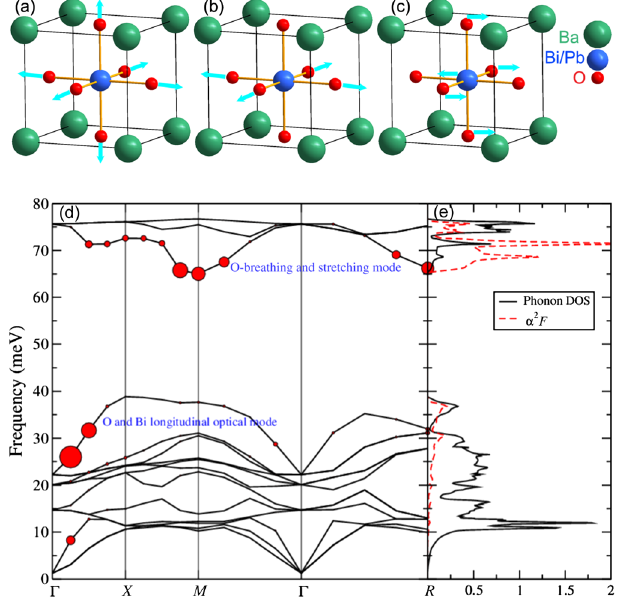
FIG. 1. Top panel: Crystal structure of BaBiO The arrows show (a) the oxygen breathing, (b) the oxygen stretching, and (c) oxygen and bismuth longitudinal optical vibration modes (the ferroelectric longitudinal optical mode). Bottom panel: (d) Phonon spectra and mode- and momentum q -dependent electron-phonon-coupling strength (cid:4) proportional to the size of the circle at each q point) and (e) the corresponding phonon density of states and the Eliashberg function (cid:2) 2 F ð ! Þ of 0.4 hole-doped BaBiO